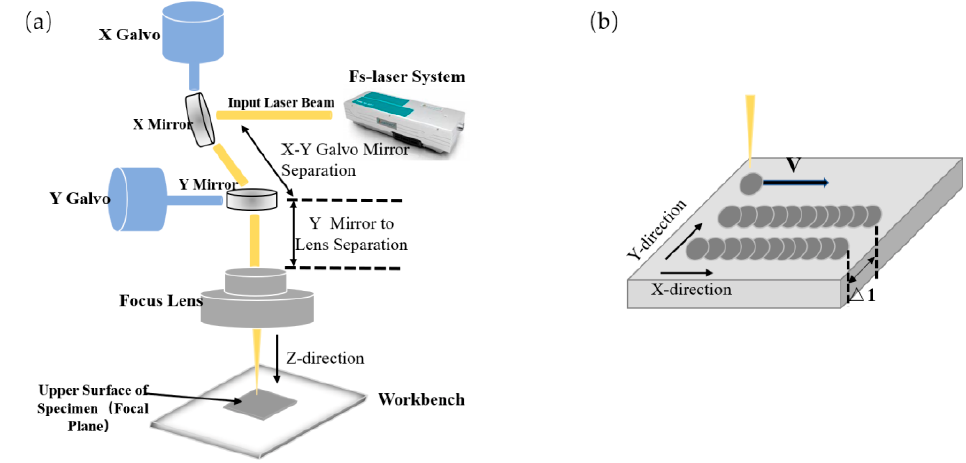
Figure 1. ( a ) The femtosecond galvanometer scanning system; ( b ) schematic of laser scanning.